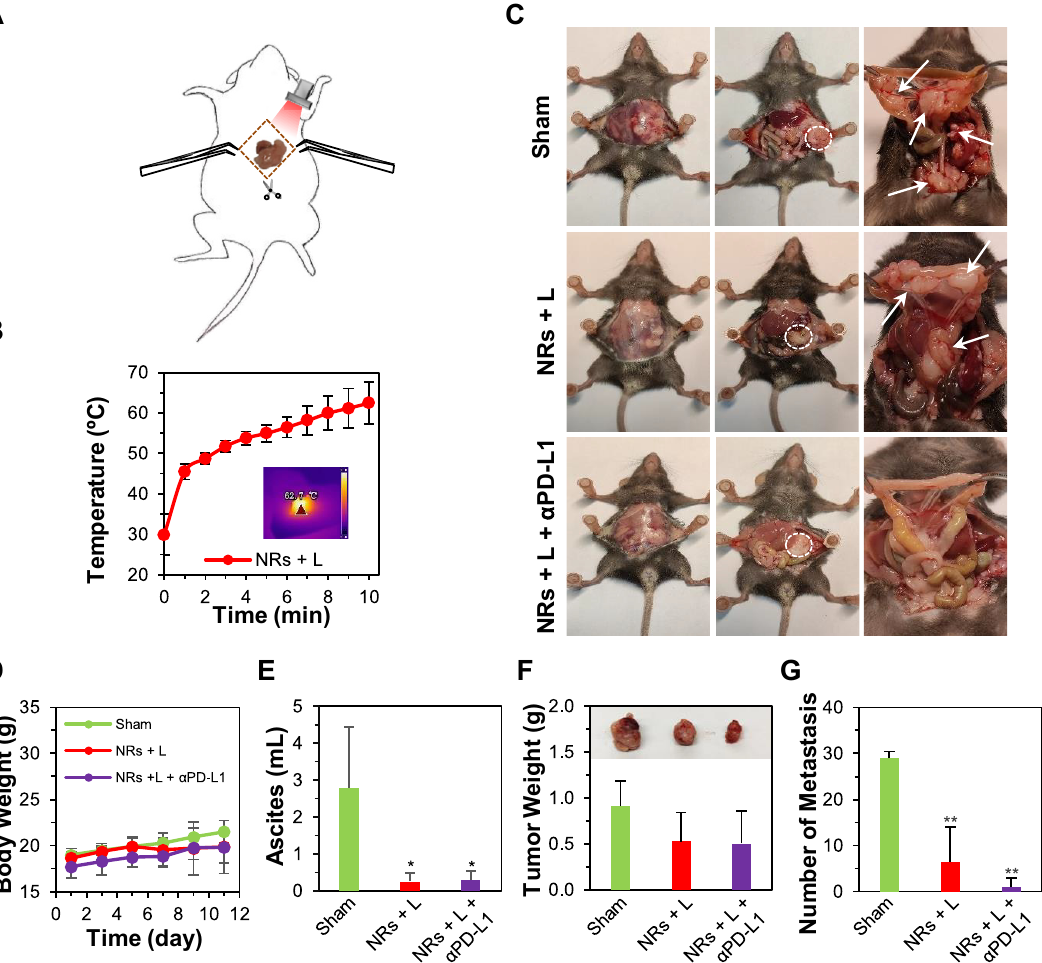
Figure 6: Therapeutic efficacy of combination therapy on orthotopic pancreatic tumors. (A) Surgicalexposureof orthotopicpancreatictumor forlaserirradiation.(B)Temperatureelevationsandnearinfrared thermalimage(insert) on tumor surface during laser irradiation ( n = 4). (C) Images of tumor-bearing mice. Left column: Comparison of the amount of ascites. Middle column: Comparison of the size of orthotopic pancreatic tumors. Right column: Comparison of the number of mesenteric metastases. (D) The changes of body weights of mice after different treatments ( n = 4). (E – G) Volume of ascites (E), weight of orthotopic pancreatic tumors (F), insert: representative images of the tumors collected from the mice), and number of mesentery metastases (G) from treated mice. ( n = 4, * P < 0.05, ** P <